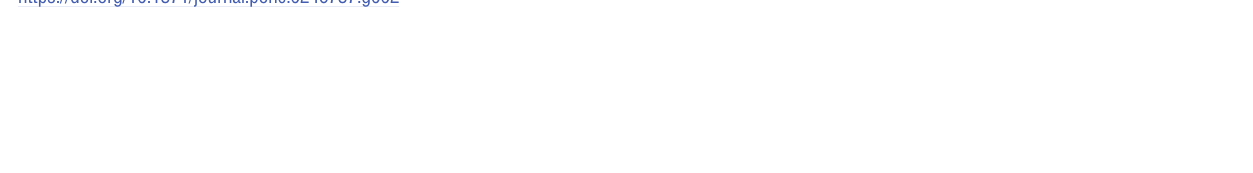
PLOS ONE | https://doi.org/10.1371/journal.pone.0246737 February 12, 2021 10 /